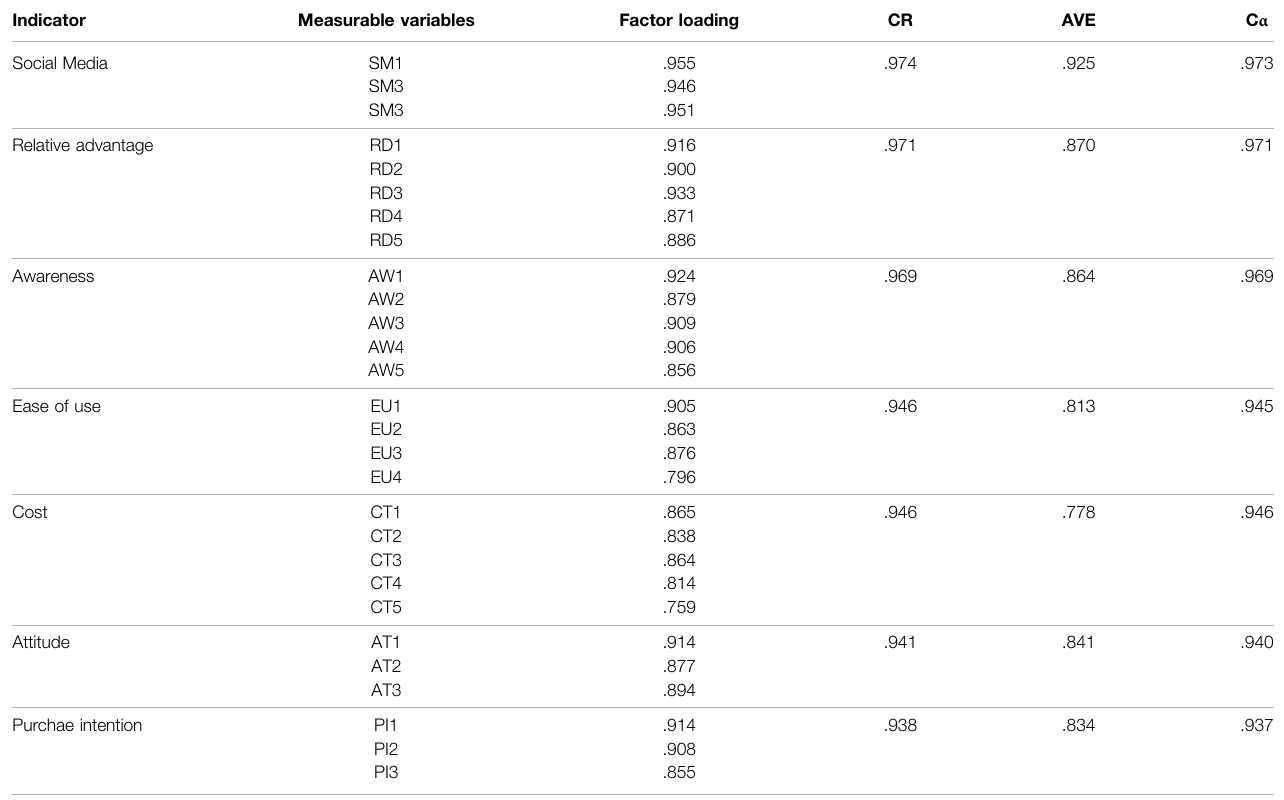
TABLE 2 | Variables of exploratory factor analysis, descriptive statistics, and con fi rmatory factor analysis.